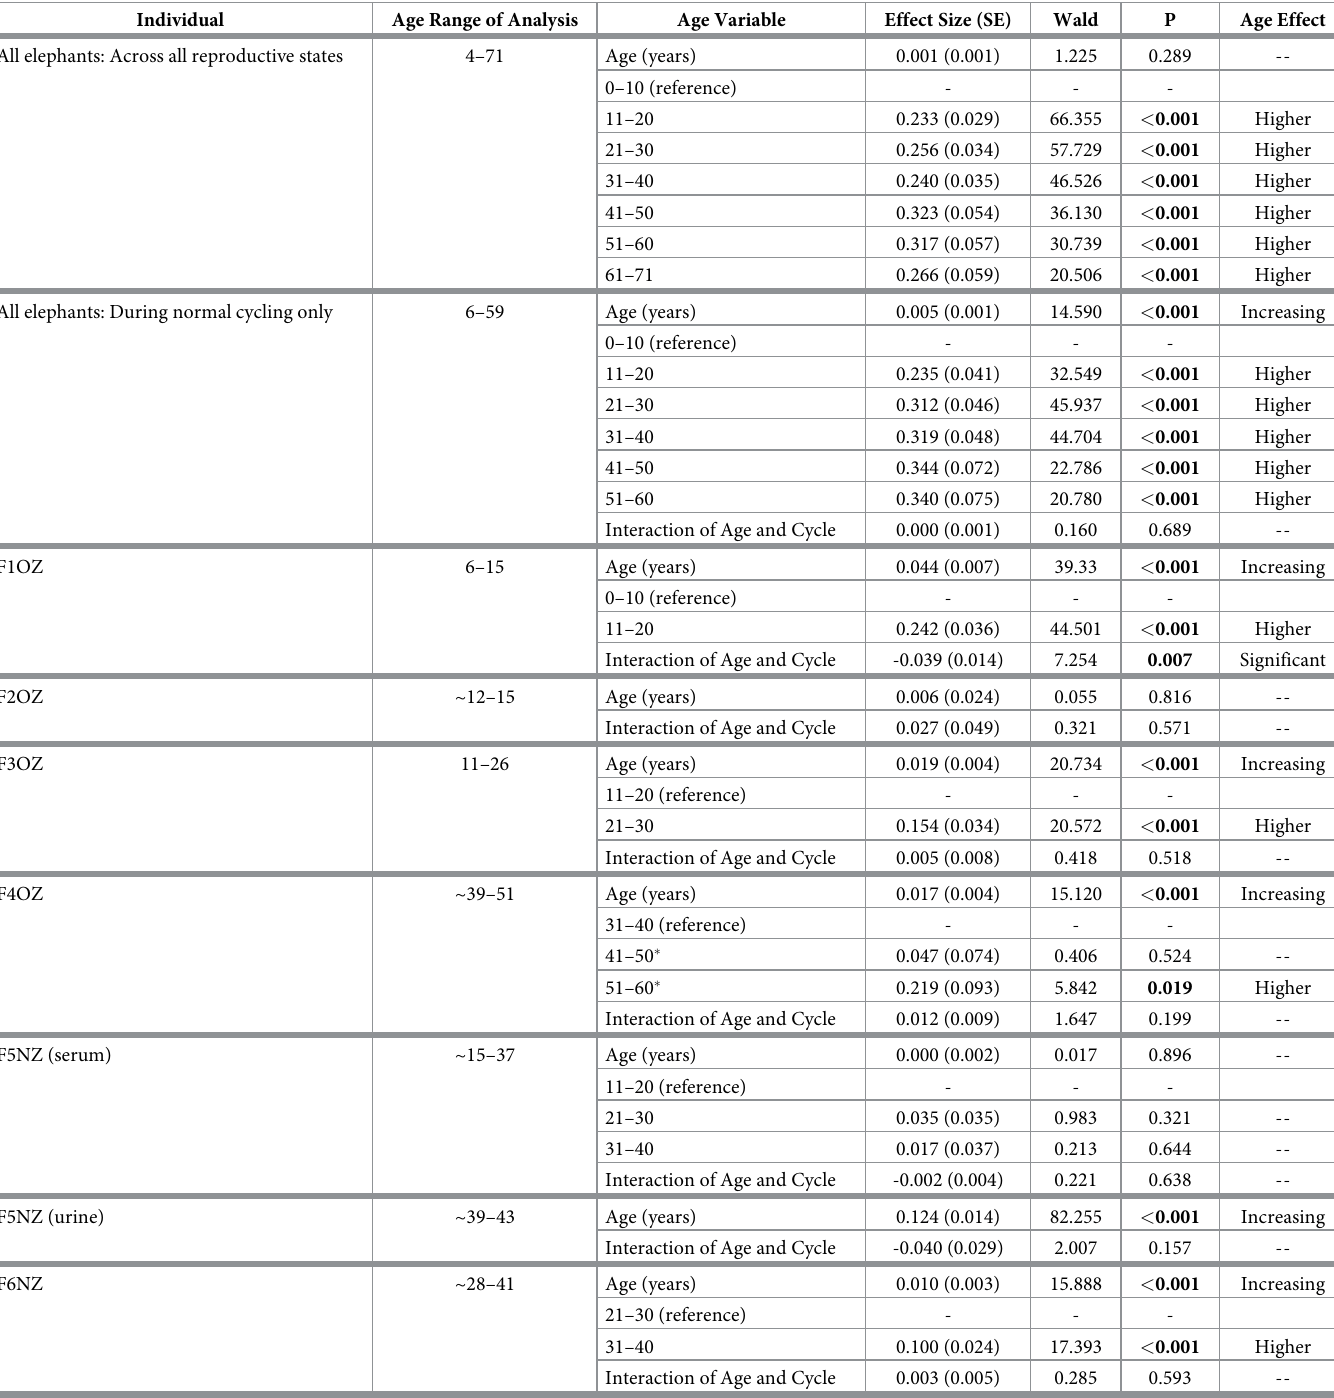
Table 3. Age as a predictor of adrenal GC activity. Individual, age range of analysis, age variable (age, age category, interaction of age and cycle), effect size with standard error (SE), Wald statistic, and p-value from GLMMs; and relative effect of age if significant. Age effect for individuals was modelled only during periods of normal cycling. Degrees of freedom (df) was 1 in all pair-wise comparisons. Females listed in order of age during analysis.